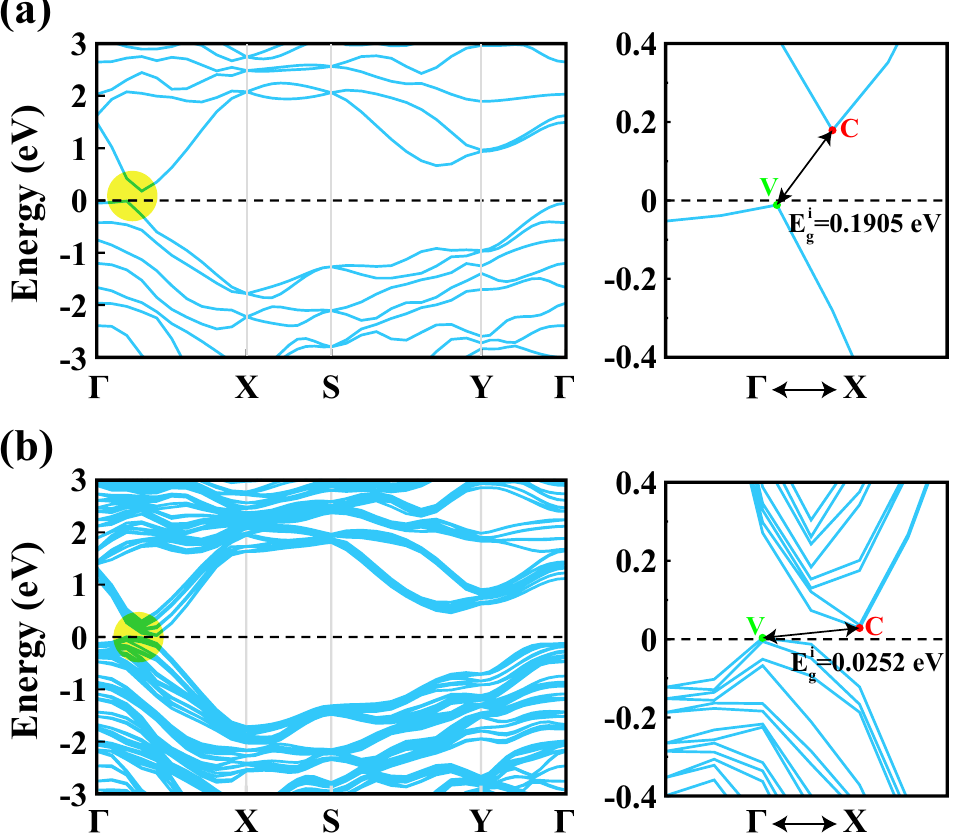
Figure 2. Electronic energy band structures, E n ( k ) , calculated with the HSE06 functional including SOC along major symmetry directions of the 2D Brillouin zone for ( a ) 1L and ( b ) 4L 1T ′ WTe 2 . The Fermi level (black- dashed line) is set to zero energy. The arrows highlight the indirect band gaps ( E i g ) occurring along the Ŵ − X direction. The conduction band minimum and valence band maximum are indicated by C and V, respectively.